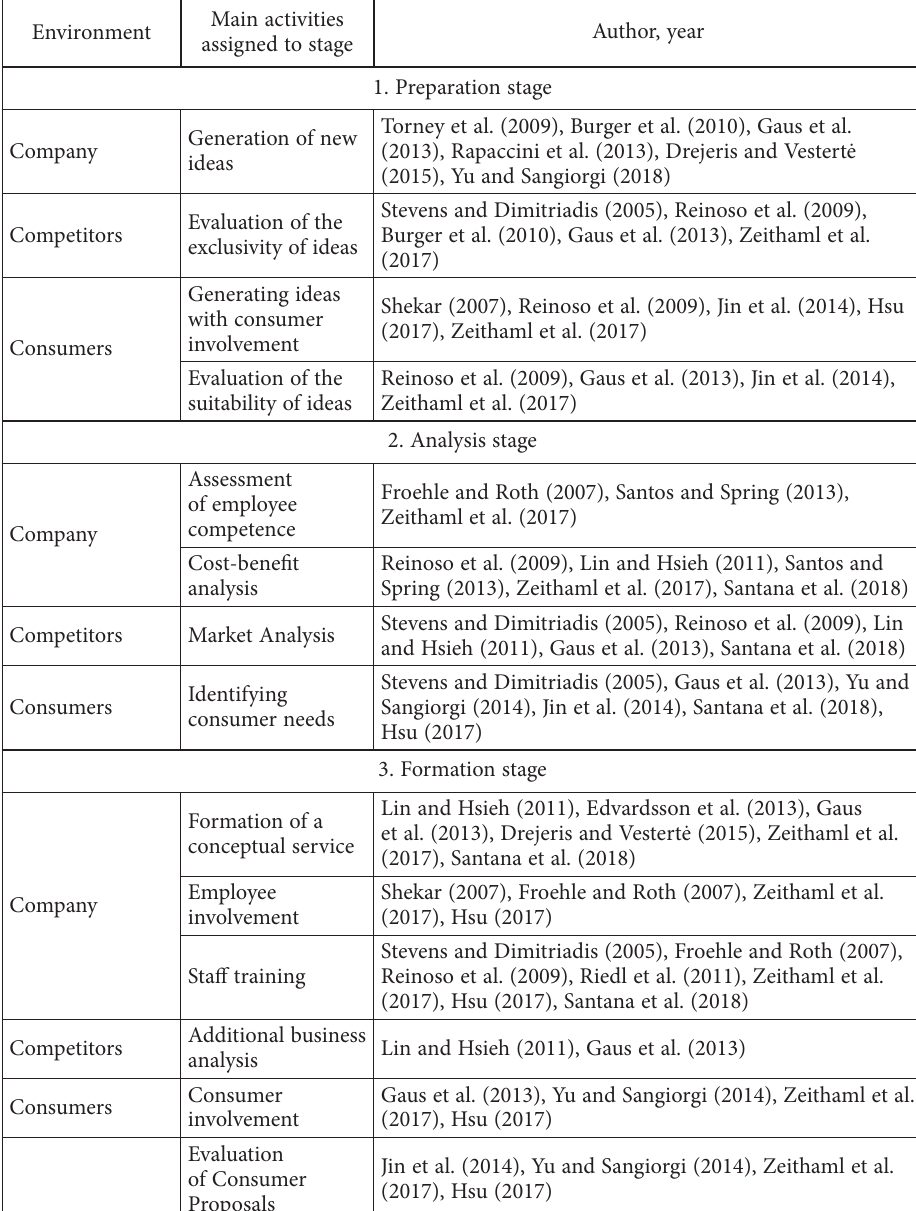
Table 2. Main activities included in preparation, analysis, formation and realization stages of NSD process (source: Švogžlys, 2020)